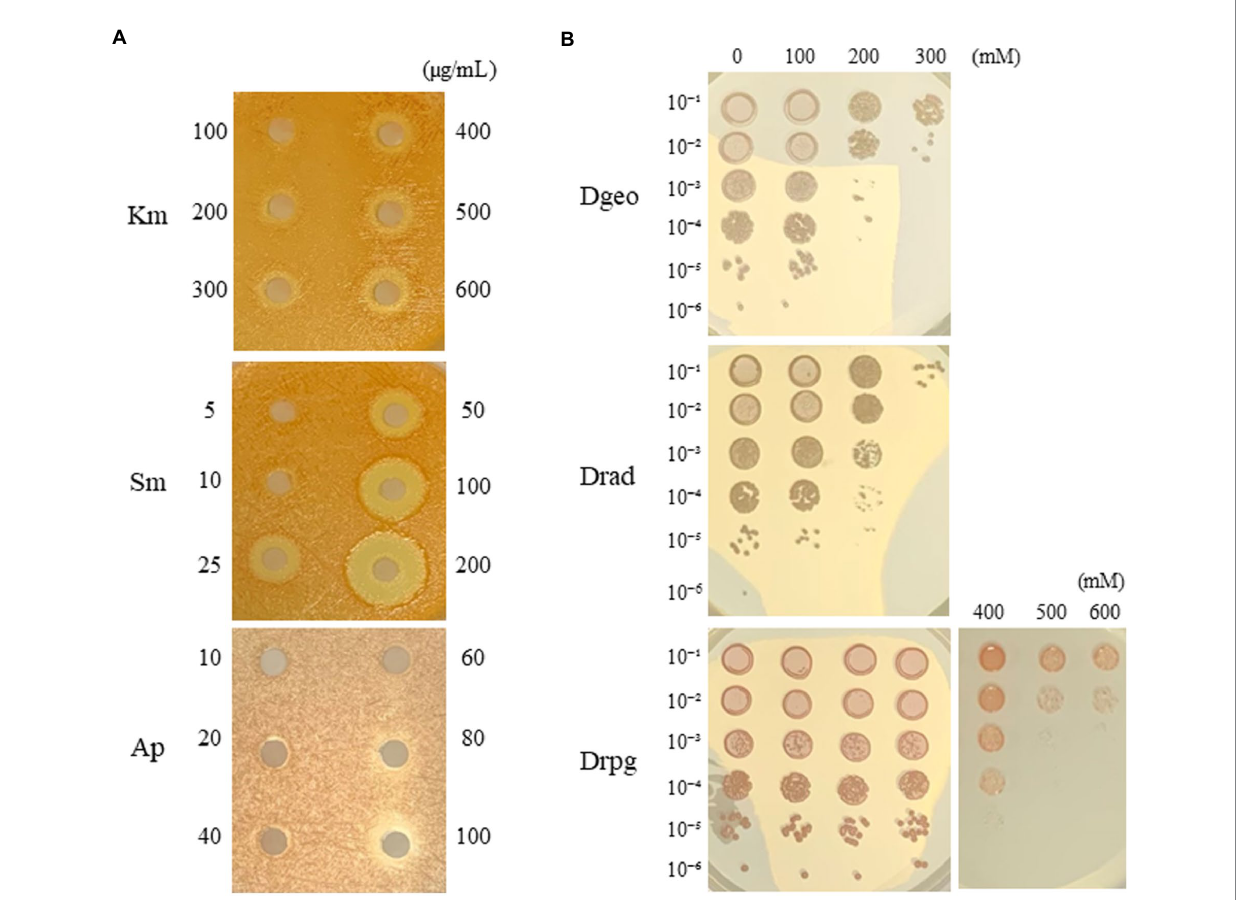
FIGURE 1 Minimum inhibitory concentration (MIC) measurement of kanamycin, streptomycin, and ampicillin via the disk diffusion method on D. radiopugnans DY59 (A) and viability assay under different concentrations of H 2 O 2 among Drad, D. radiodurans ; Dgeo, D. geothermalis ; Drpg, D. radiopugnans (B) . Three Deinococcus species were grown to OD 600 of 4.0, harvested, and resuspended by 0.9% NaCl to OD 600 of 2.0. H 2 O 2 treatment was performed on different final concentrations for 1 h then, serially diluted and spotted on TGY